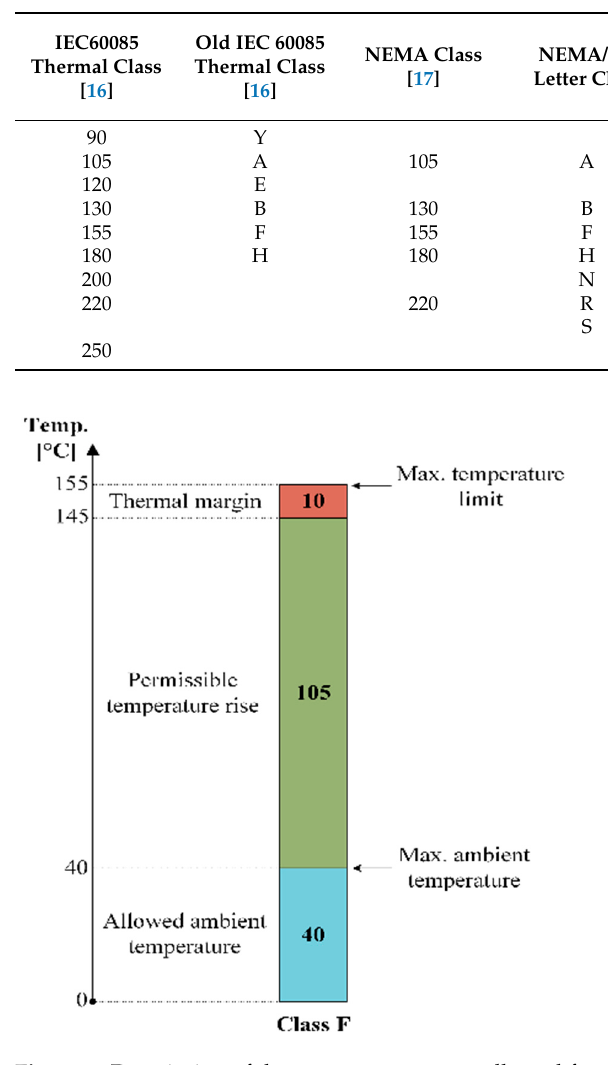
Figure 2. Description of the temperature range allowed for the class F of insulation.